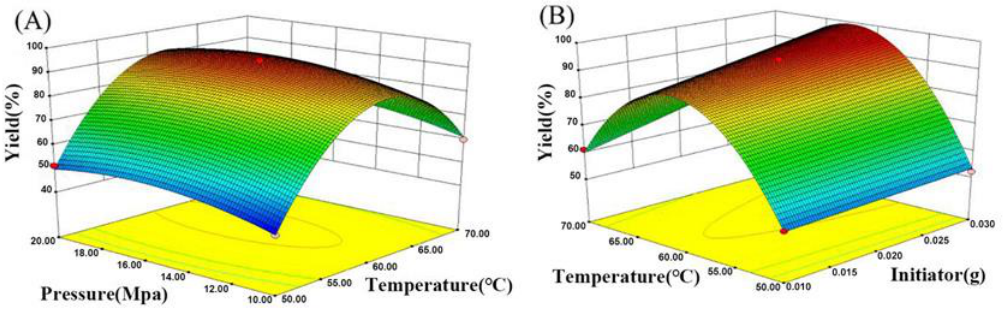
Figure 2. ( A ) Response surface on yield versus temperature and pressure; ( B ) response surface on yield versus temperature and initiator.